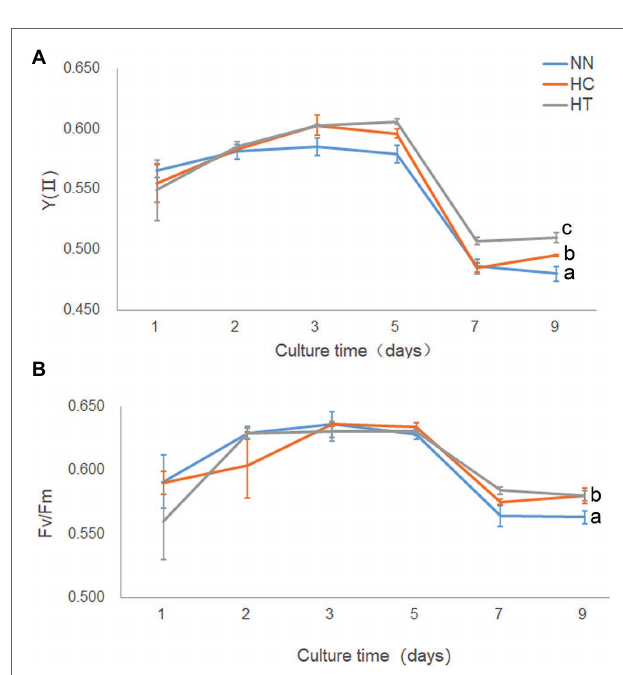
FIGURE 2 | Photosynthetic performance and growth in Symbiodinium sp. under HC and HT and NN conditions. X-axis, culture times; Y-axis, YII (A) and Fv/Fm (B) . Data points are the means of triplicates and error bars represent the standard deviation. Letters a–c represent significant differences (value of p < 0.05) between groups evaluated by Student’s t